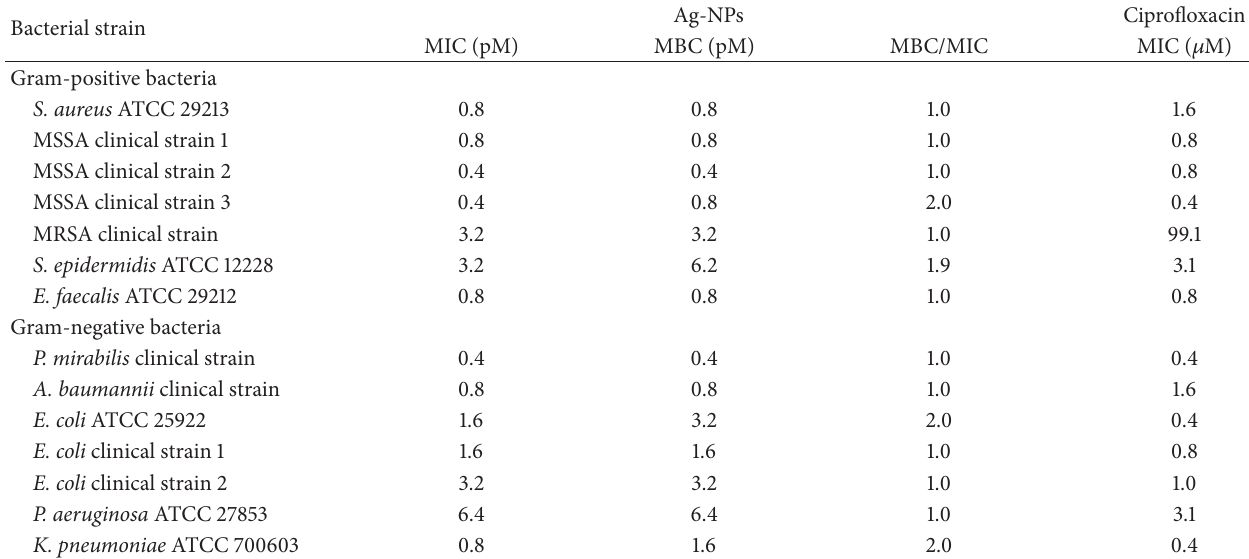
Table 1: Minimum inhibitory concentration (MIC) of Ag-NPs and ciprofloxacin and minimum bactericidal concentration (MBC) of Ag-NPs for different bacterial species.